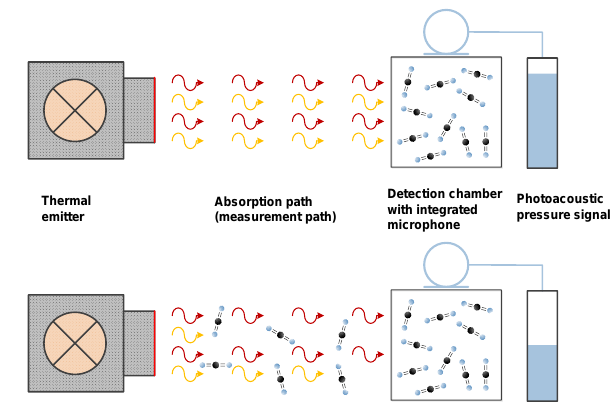
Figure 2. Working principle of the sensor set-up. Part of the light from the thermal emitter is absorbed in the measurement path if IR active molecules are present, leading to a decreased photoacoustic pressure signal. Figure 3. Transmission spectrum of 1000ppm CO 2 in N 2 at 4mm absorption length under standard conditions (296K, 1